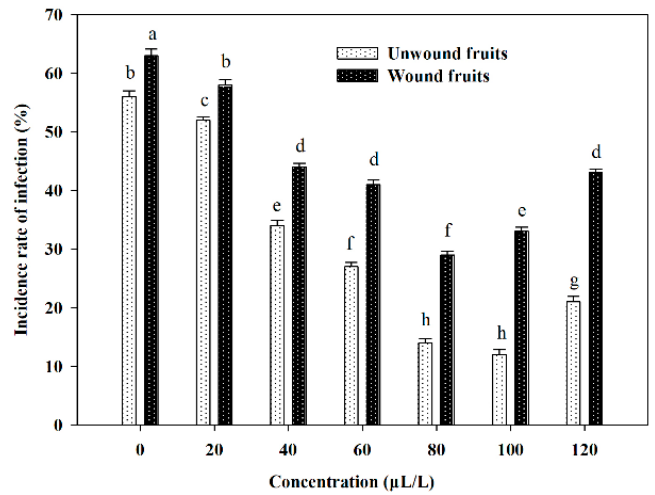
Figure 5. Inhibition e ff ect on postharvest infection in wound and unwound sweet cherry fruits by clove oil. Note: Di ff erent lowercase letters indicate a significant di ff erence at the 5% level. 2.4. Observing the E ff ect of Clove Oil on Hyphal Morphology and Cellular Ultrastructure SEM could intuitively reflect the morphological changes of C. gloeosporioides . In the control samples (Figure 6A,C), the hyphae was uniform and robust with a plump and smooth surface, while the treated mycelia (Figure 6B,D) became shrank, collapsed and winding following contact with clove oil at a concentration of 400 µ L / L. The e ff ects of clove oil on the ultrastructure of C. gloeosporioides observed by TEM are shown in Figure 6E,F. The control revealed a typical fungal ultrastructure of which all organelles had normal and regular appearance, and were clearly identified. After treatment with clove oil, the structures of most organelles were indistinct and unidentifiable with deformed and disorganized mitochondria. The major changes included cell wall and endomembrane system. In treated fungi, the cell wall showed obvious thickening, becoming rough and villous, and the cell membrane was partially detached from the cell